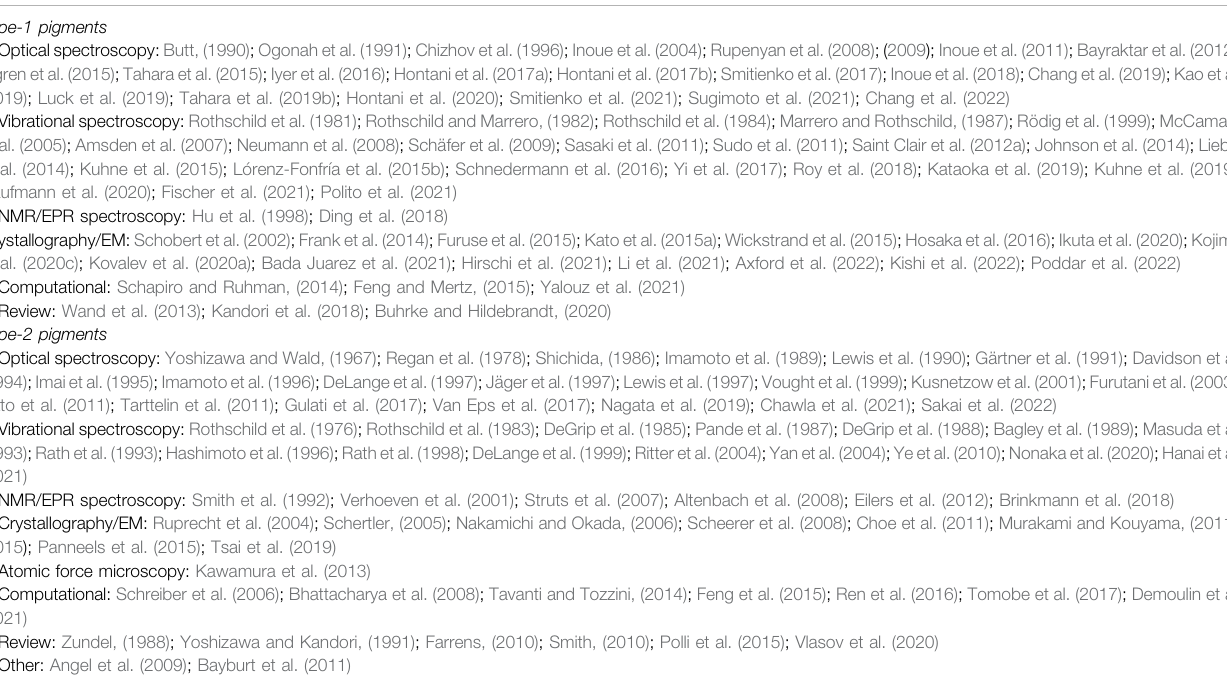
TABLE 4 | Selected additional citations for the section “ Photochemical properties ”